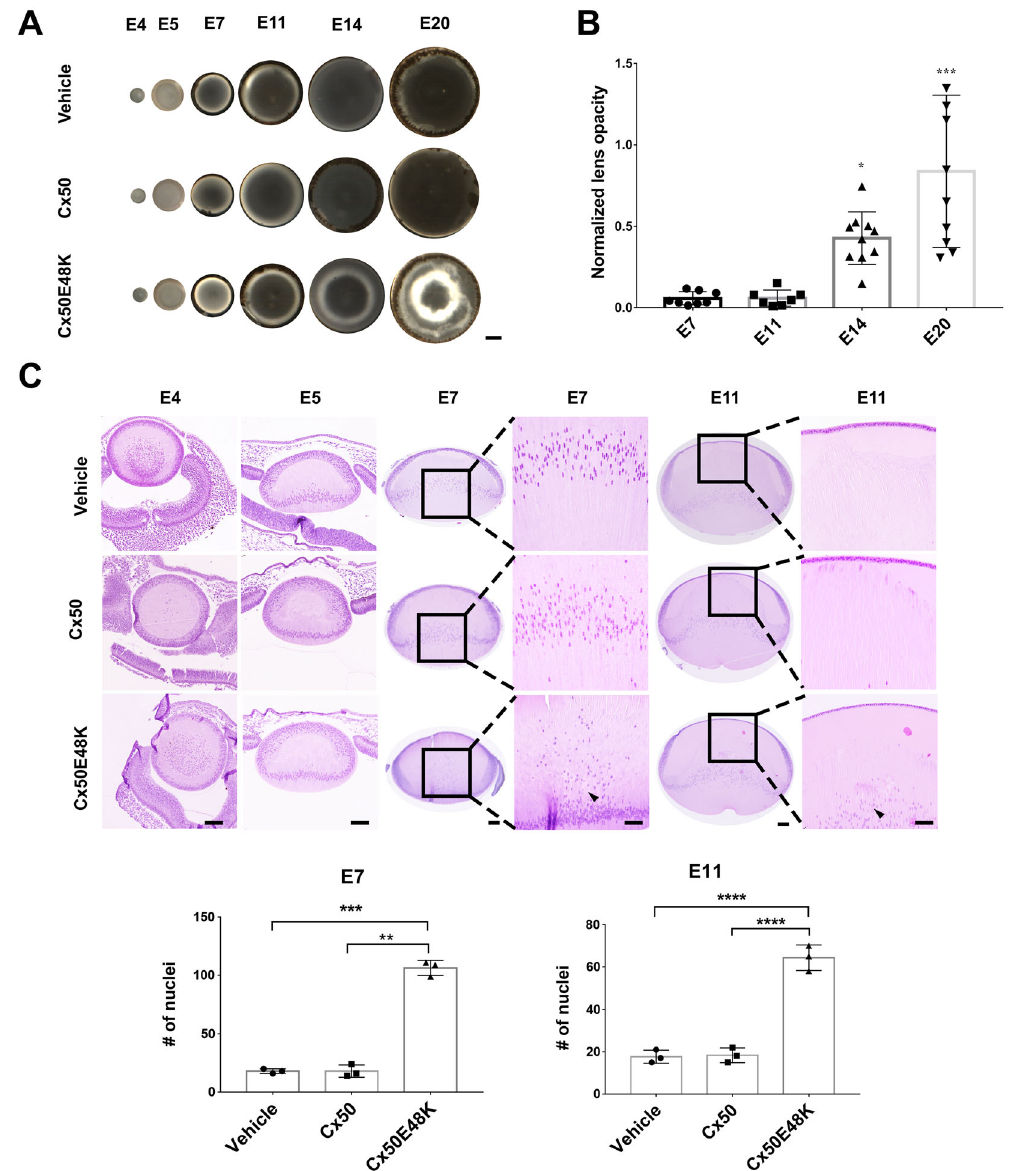
Fig. 3 Exogenous expression of the dominant-negative Cx50E48K mutation induces the formation of nuclear cataracts. A Optical images of embryonic chick lenses injected with a recombinant retrovirus containing vehicle, Cx50 or Cx50E48K were taken at embryonic day (E), 4, 5, 7, 11, 14, and 20 under identical magni fi cation. Scale bar: 400 µ m. B The relative magnitude of cataracts was measured and quanti fi ed by Image J and normalized with the contralateral lens. The extent of opacity of retrovirus injected lenses was normalized by subtracting that of the contralateral lens and then dividing by that of the contralateral lens. All data are presented as mean ± SEM. * P < 0.05, *** P < 0.001. n = 8 for E7, n = 7 for E11, n = 10 for E14 and E20. C Representative images of H&E staining at various stages of embryonic lens development (upper panel). Black arrowhead indicated the abnormal nuclear distribution in Cx50E48K expressing lenses. Scale bar: 50 µ m. The nuclei number was counted and the quanti fi cation results are shown in the bottom panel. All data are presented as mean ± SEM. ** P < 0.01, *** P < 0.001, **** P < 0.0001. n =